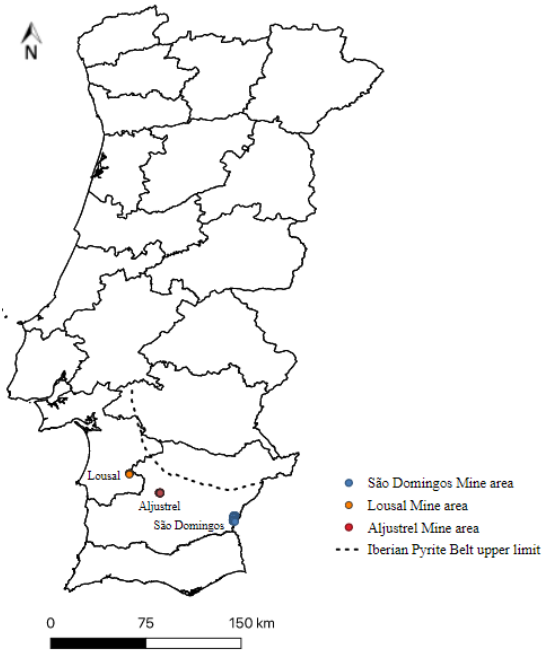
Figure 1. Map evidencing the upper limit of the Iberian Pyrite Belt, with the most important mining districts that were responsible for extensive environmental impacts: Lousal (and Caveira), Aljustrel, and São Domingos.